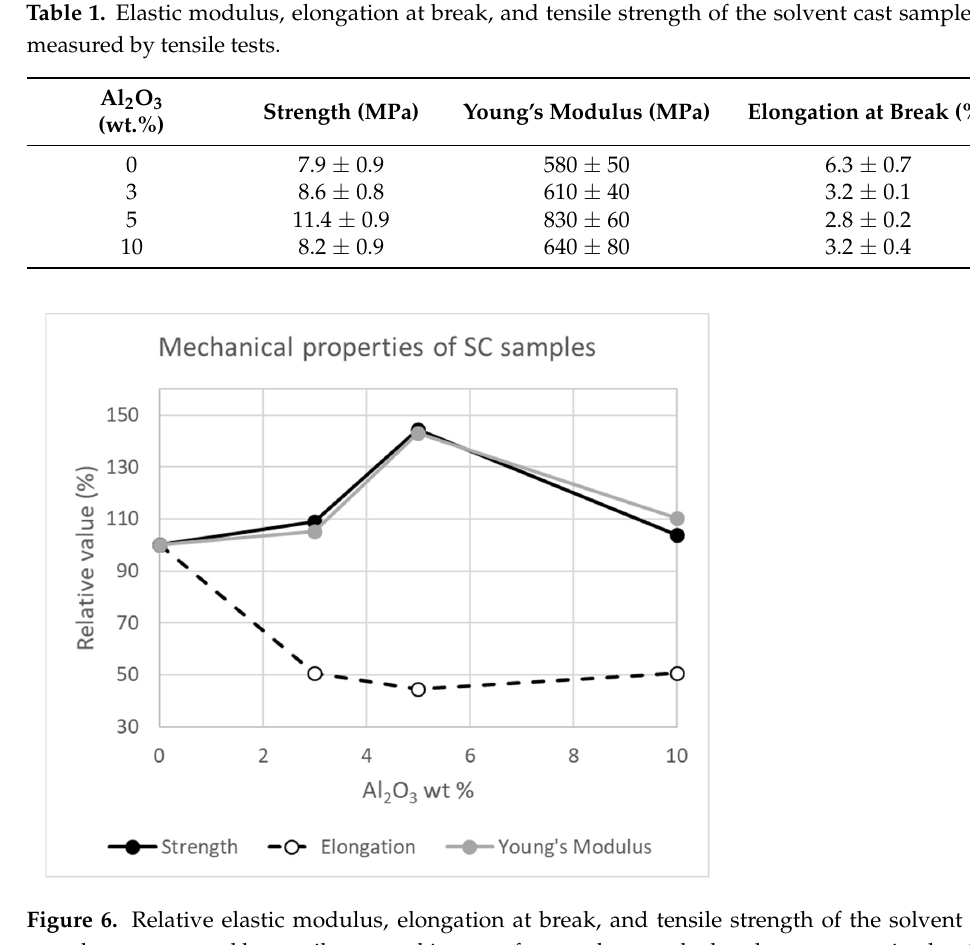
Figure 6. Relative elastic modulus, elongation at break, and tensile strength of the solvent cast samples as measured by tensile tests, taking as reference the sample that does not contain alumina.